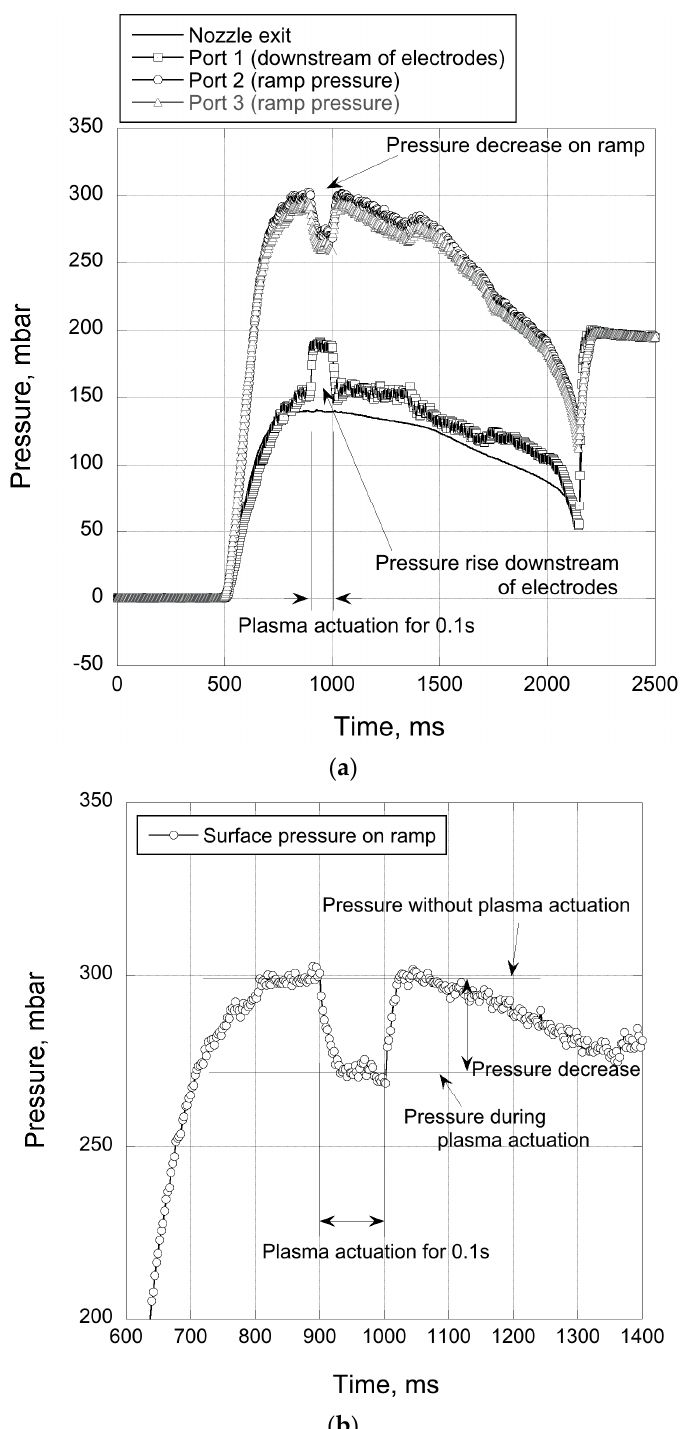
Figure 7. Pressure timeseries in typical test: ( a ) Pressure variation during wind tunnel test; ( b ) definition of pressure decrease. of pressure